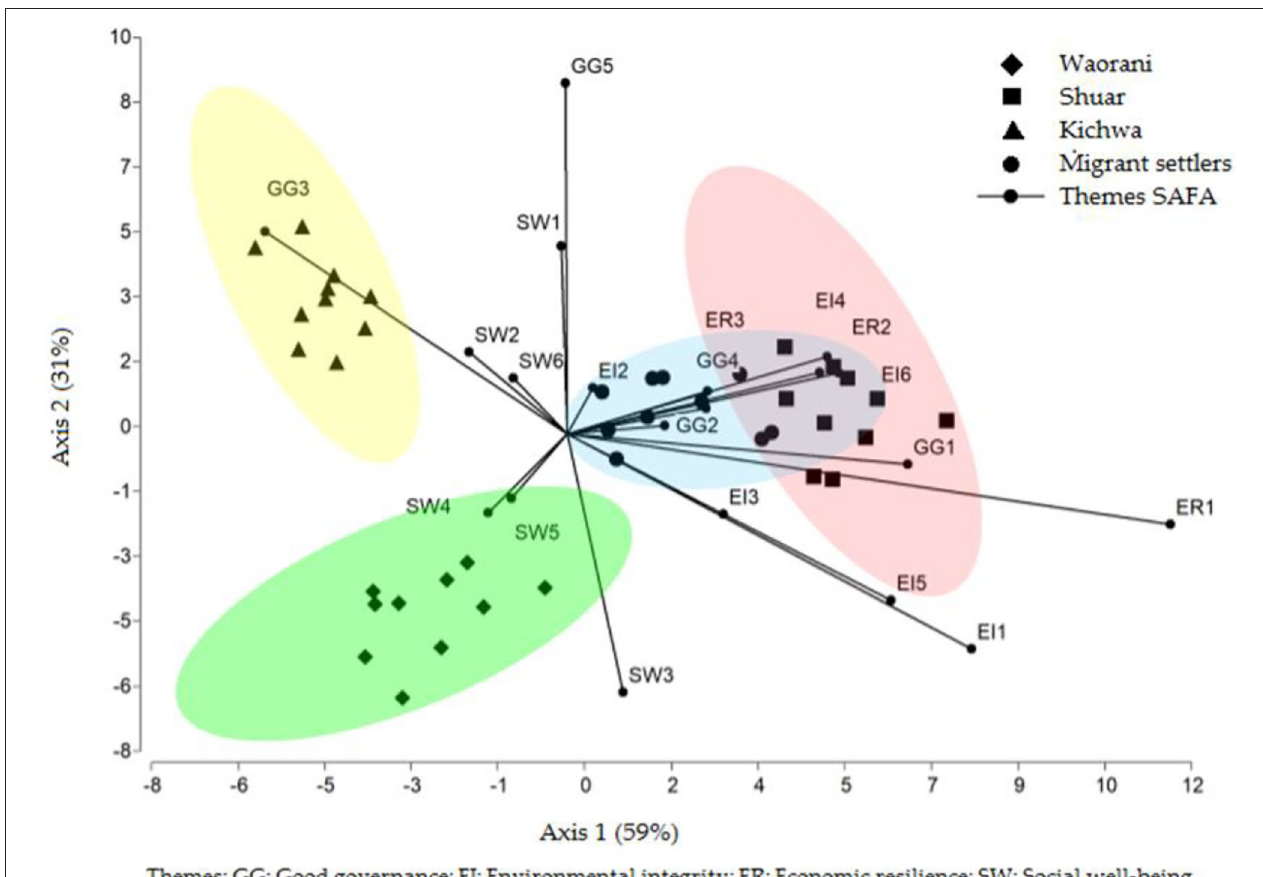
FIGURE 3 | Multivariate discriminant analysis between sustainability issues and social groups in the Yasuní Biosphere Reserve, Amazon region of Ecuador (Themes: GG, good governance; EI, environmental integrity; ER, economic resilience; SW, social